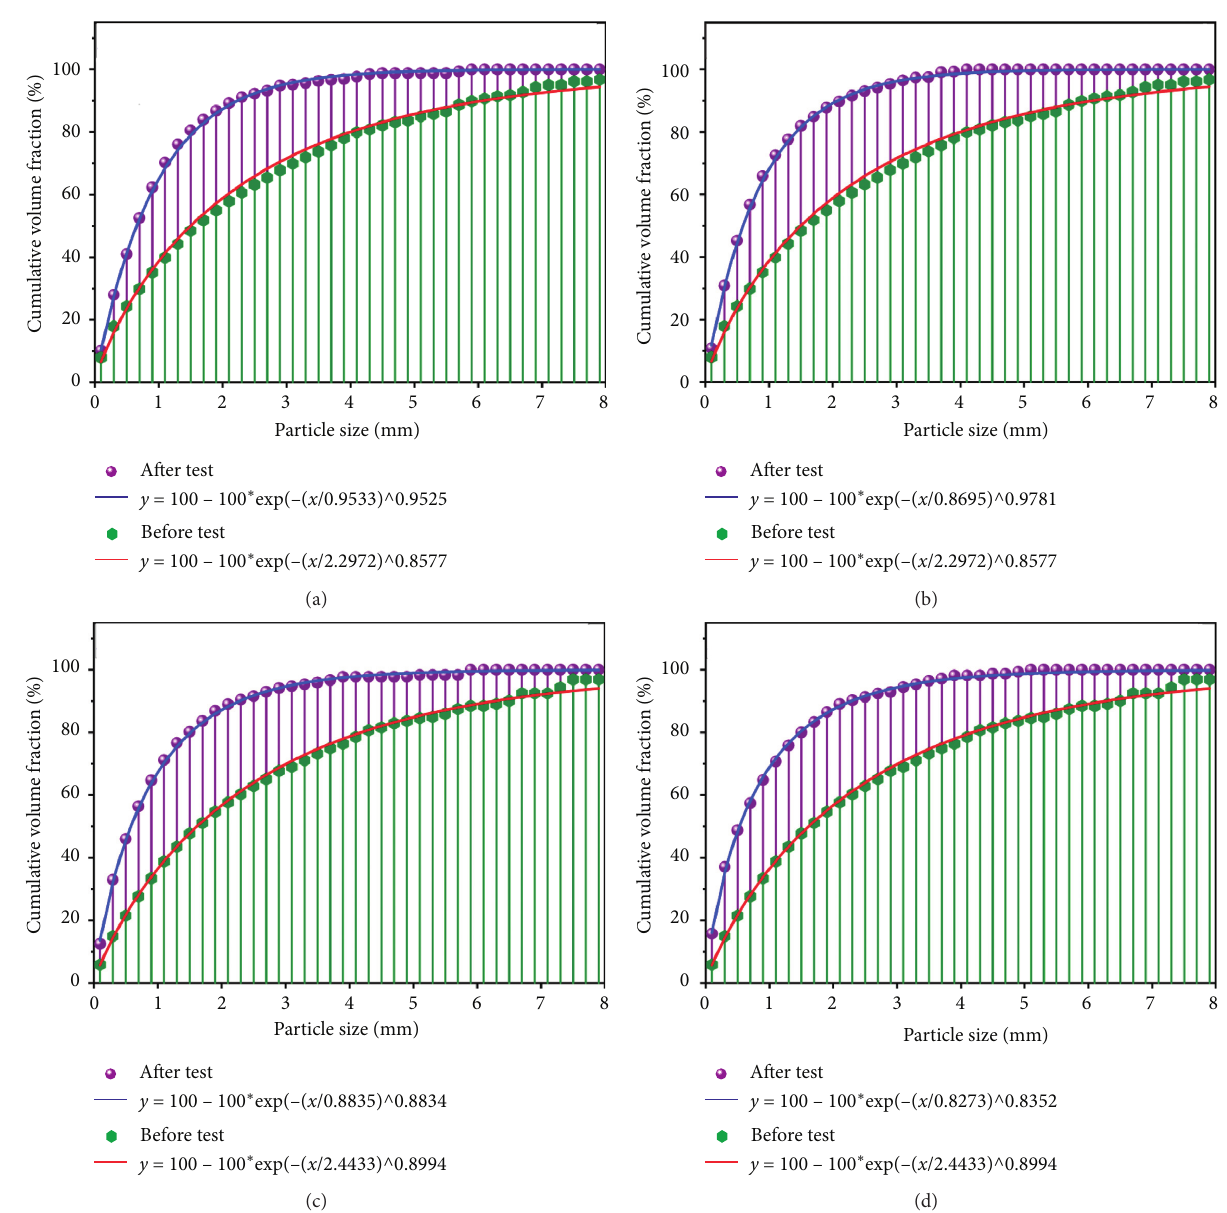
Figure 9: The cumulative distribution before and after the tests. (a) 1 # coal sample. (b) 2 # coal sample. (c) 3 # coal sample. (d) 4 # coal sample.